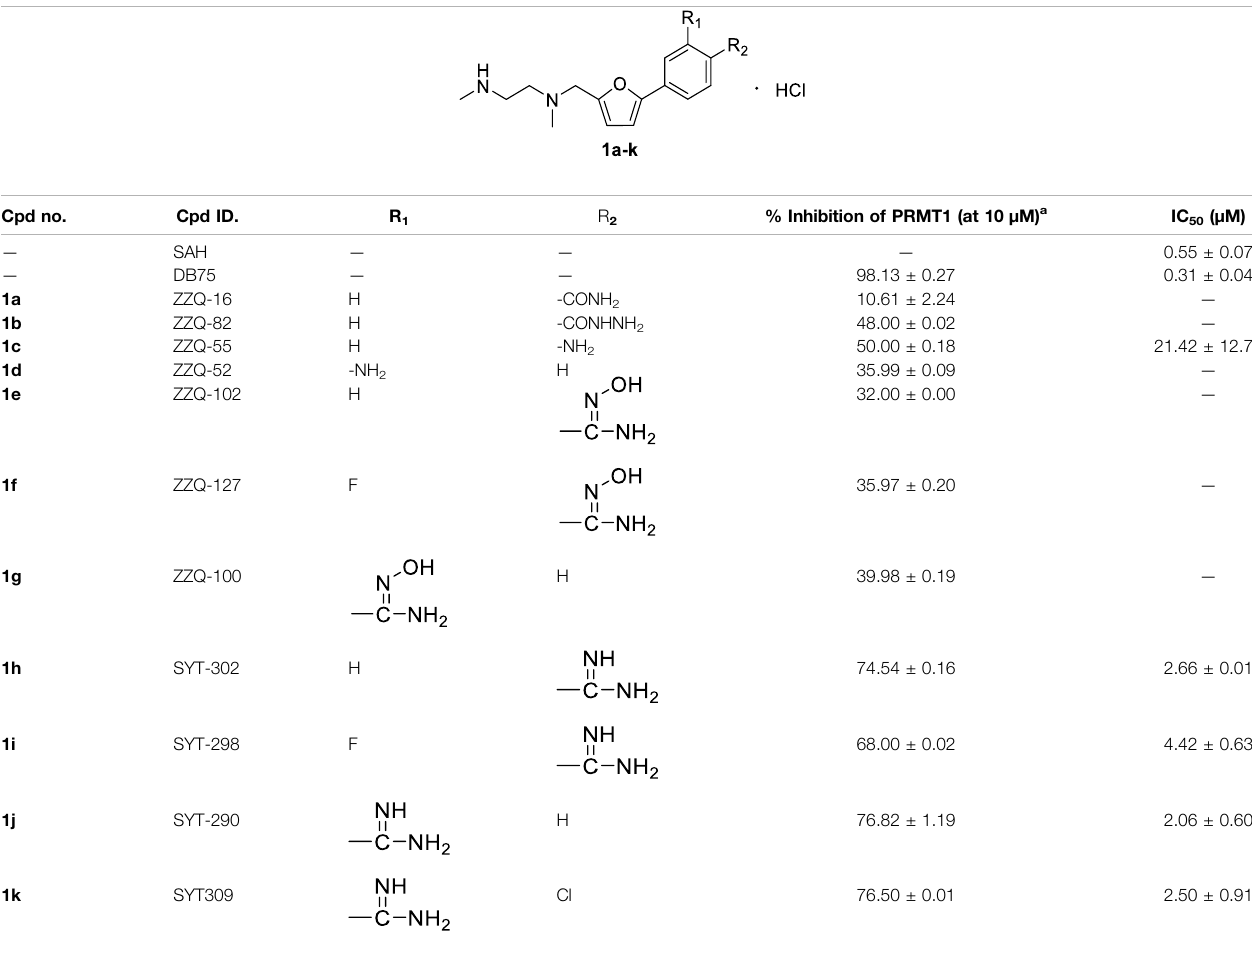
TABLE 1 | Inhibitory activities of 2,5-substituted furan derivatives 1a – k against PRMT1.